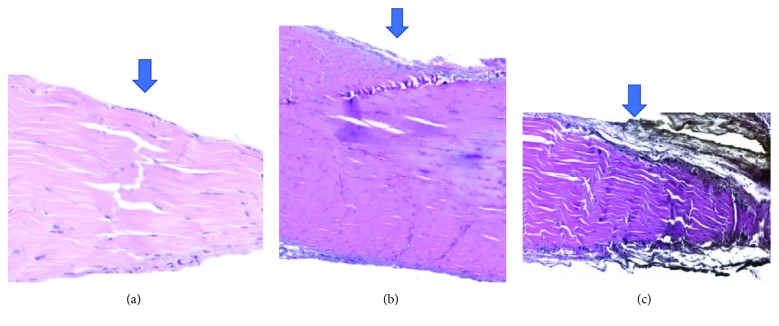
Enlarged images of tissue sections showing an eosin-stained epitendon in one cell layer (normal) or several cell layers (massive fibrosis).